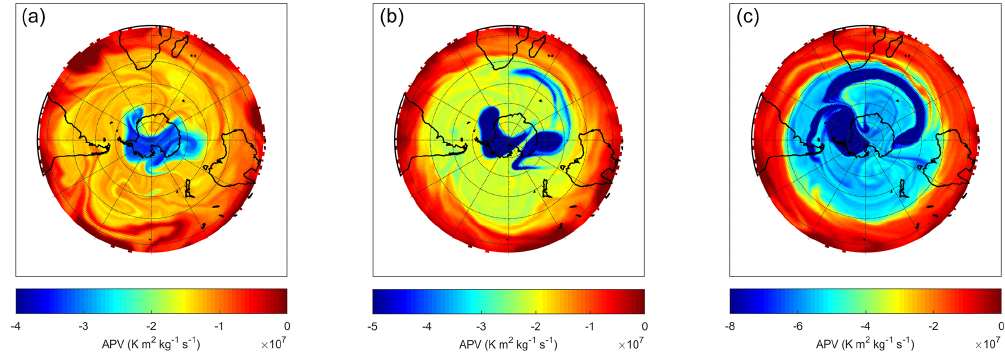
Figure 8. APV maps from MIMOSA-CHIM at 435K (a) , 485K (b) and 600K (c) on 14 November